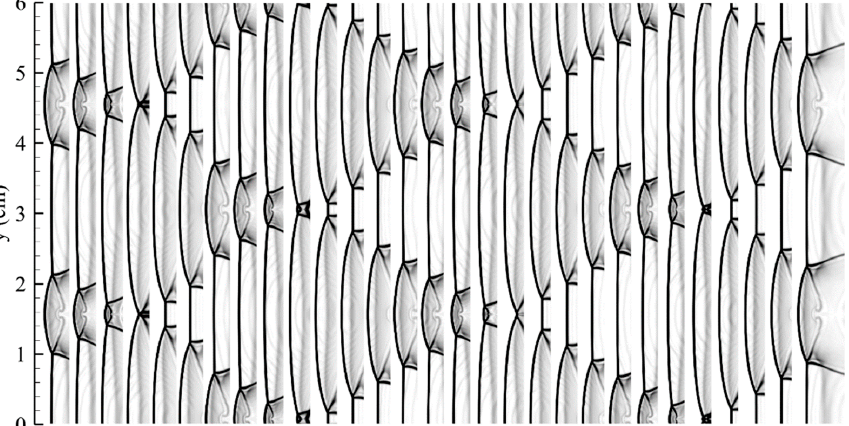
Figure 5. Triple point trajectories extracted over time.